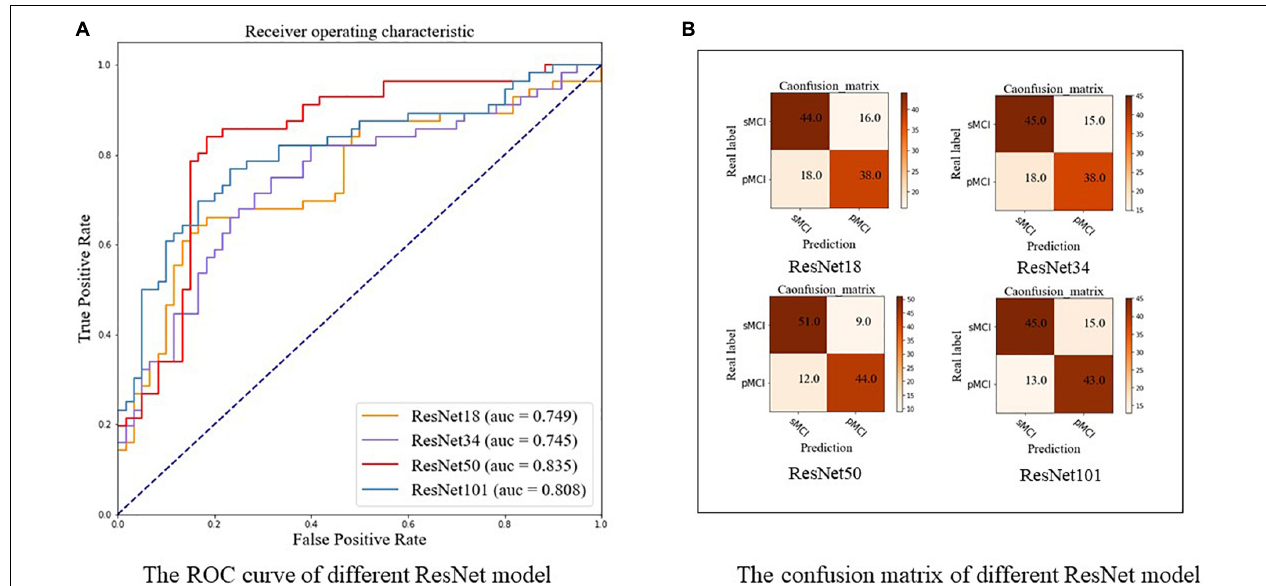
FIGURE 6 | The ROC curve and confusion matrix of different ResNet using our two-stage model. (A) The ROC curve. (B) The confusion matrix. pMCI, progressive mild cognitive impairment; sMCI, stable mild cognitive impairment.